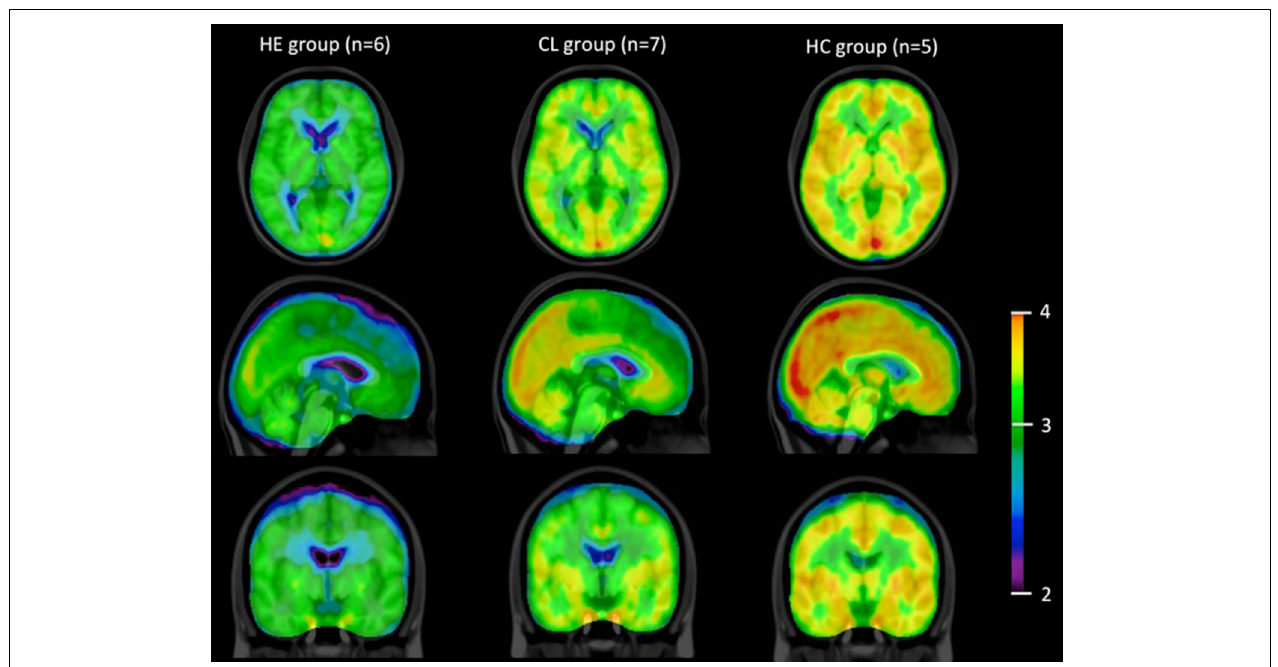
FIGURE 2 | [ 11 C]acetate PET images. Summed average [ 11 C]-PET images from time of injection of [ 11 C]acetate to 45min in the groups of patients with cirrhosis and HE (HE), patients with cirrhosis without HE (CL) and healthy subjects (HC), n, number of subjects. Data are presented on a logarithmic scale.